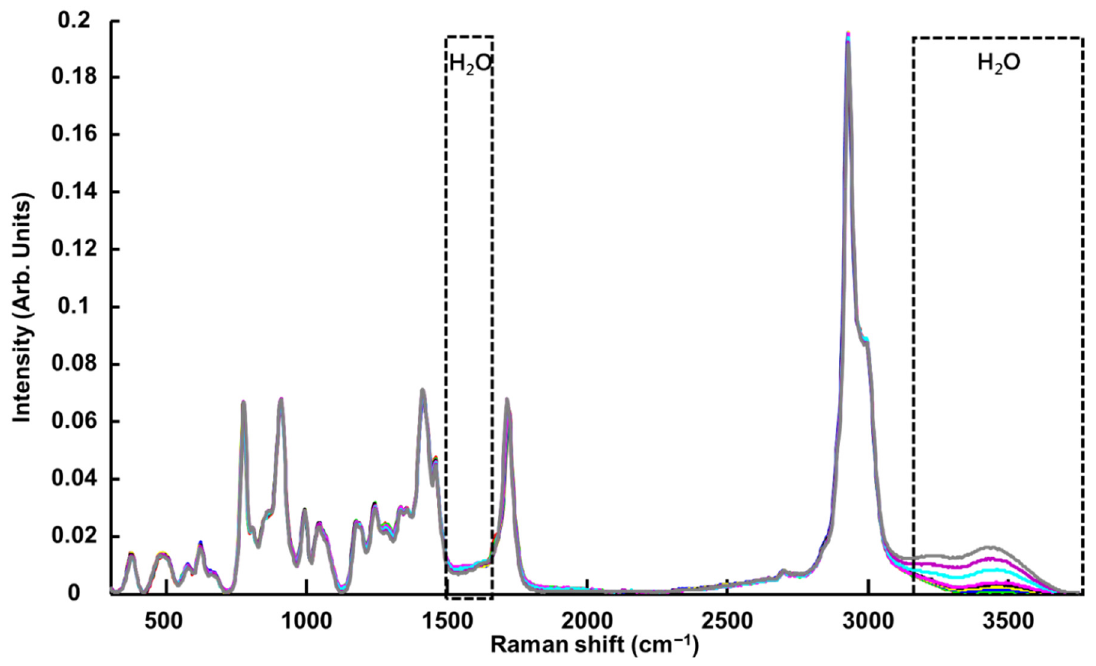
Figure 8. Mean RBVN Raman-B spectra collected from LALP. Concentrations for added water (% w/w) are respectively ~ 0% (red), 0.99% (green), 2.4% (blue), 4.7% (yellow), 6.9% (black), 9.1% (magenta), 16.7% (cyan), 23% (purple) and 28% (grey).